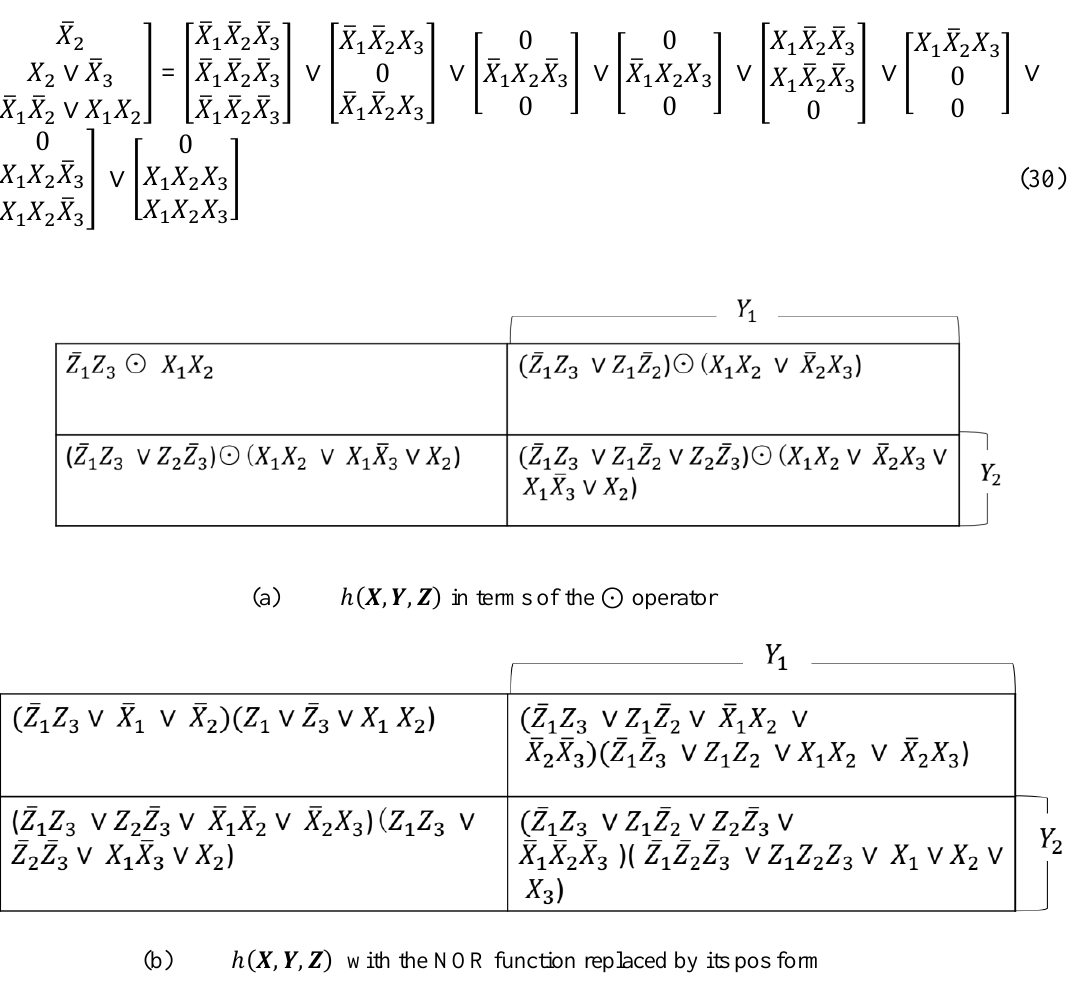
Fig. 2. A map expression of the function in Example